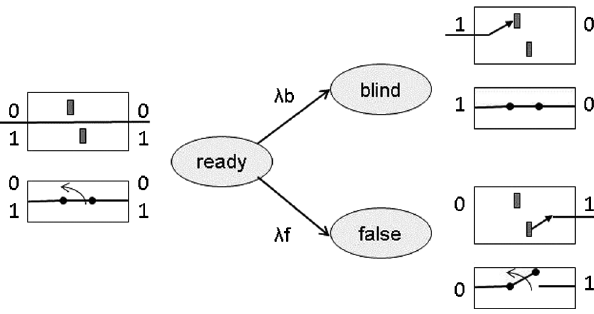
FIG. 8. State diagram reflecting component behavior.